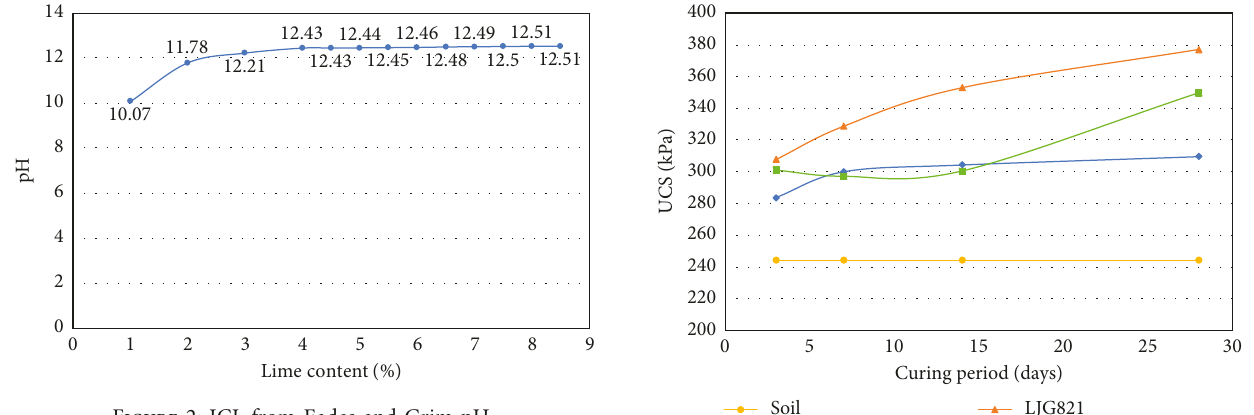
Figure 2: ICL from Eades and Grim pH.